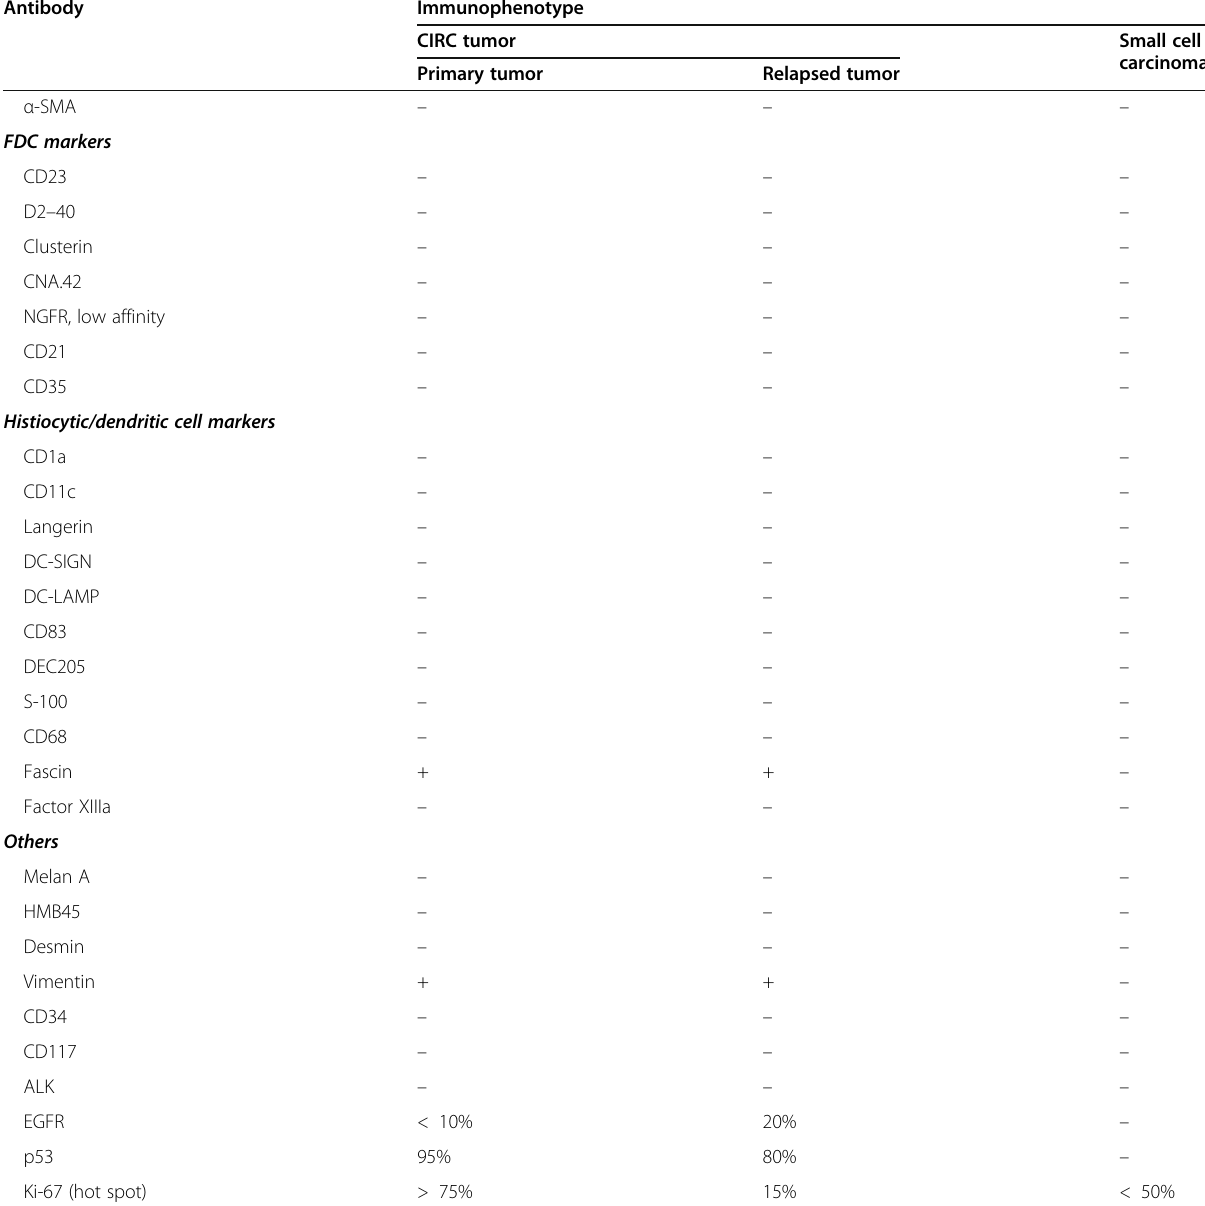
Table 1 Immunophenotypes of CIRC tumor and small cell carcinoma of this case (Continued)